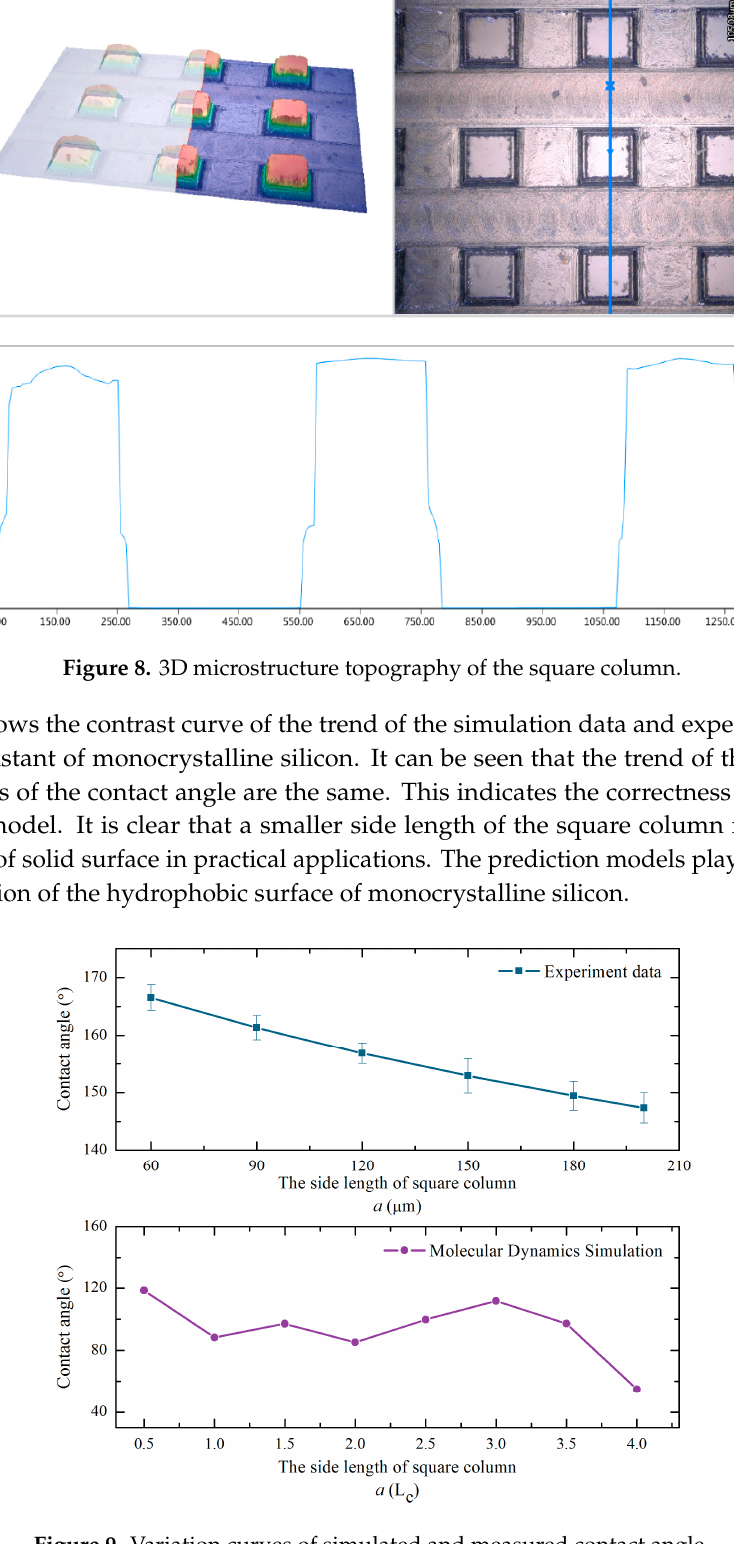
Figure 9. Variation curves of simulated and measured contact angle.